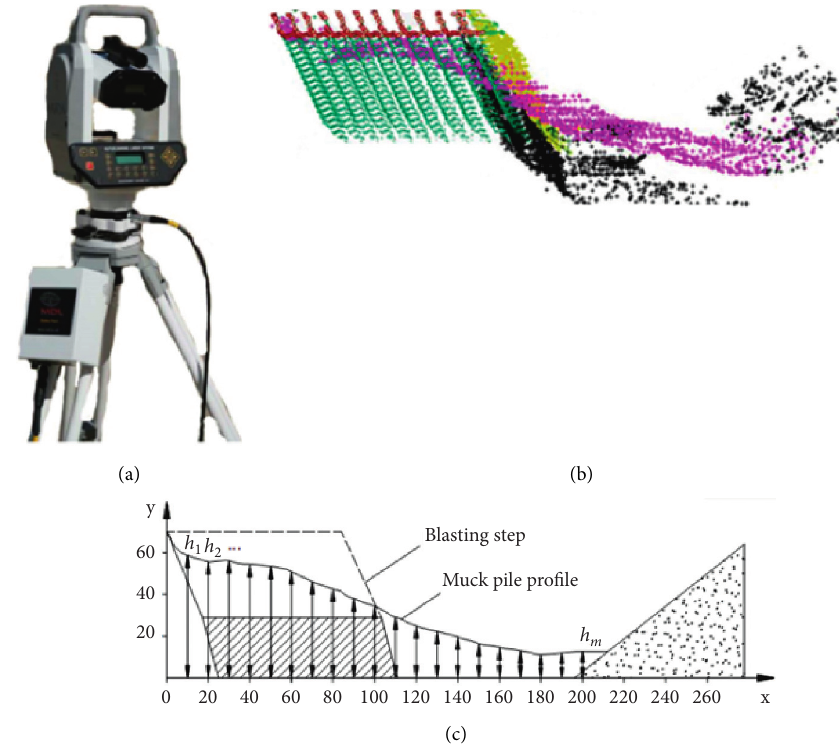
Figure 6: Three-dimensional scanning and data statistics of blasting area before and after blasting.